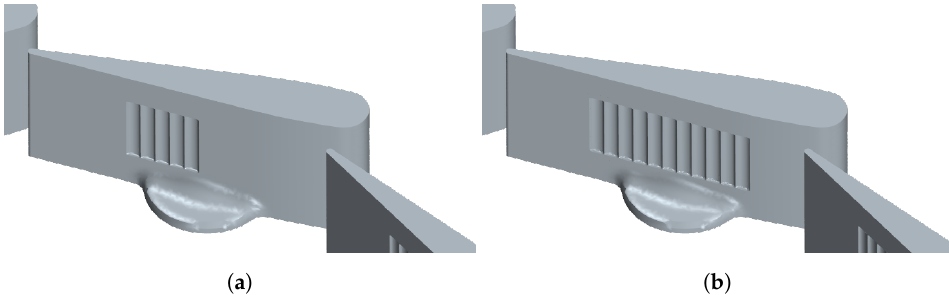
Figure 1. Stator geometry with different grooved surfaces. ( a ) Geometry with 5 grooves. ( b ) Geometry with 11 grooves.